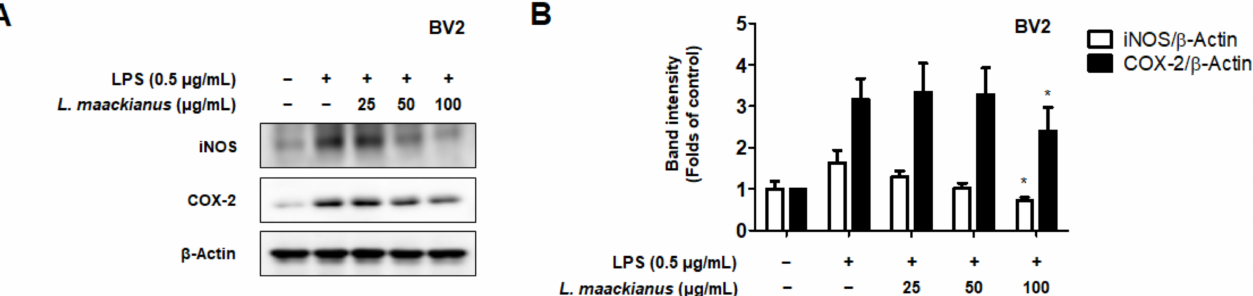
Figure 3. Effect of Lycopus maackianus methanol (MeOH) extract on inducible nitric oxide synthase (iNOS) and cyclooxygenase (COX)-2 protein levels in BV2 cells ( A ). Western blotting was performed after treating the cells with L. maackianus MeOH extract at the indicated concentrations for 3 h, followed by stimulation with lipopolysaccharide (LPS; 0.5 µ g/mL) for 24 h. The immunoblot was quantified using the ImageJ software ( B ). Band intensities were normalized to those of β -actin. Data are the average of three independent experiments. Untreated control groups were included. * p < 0.05 compared to the LPS treatment